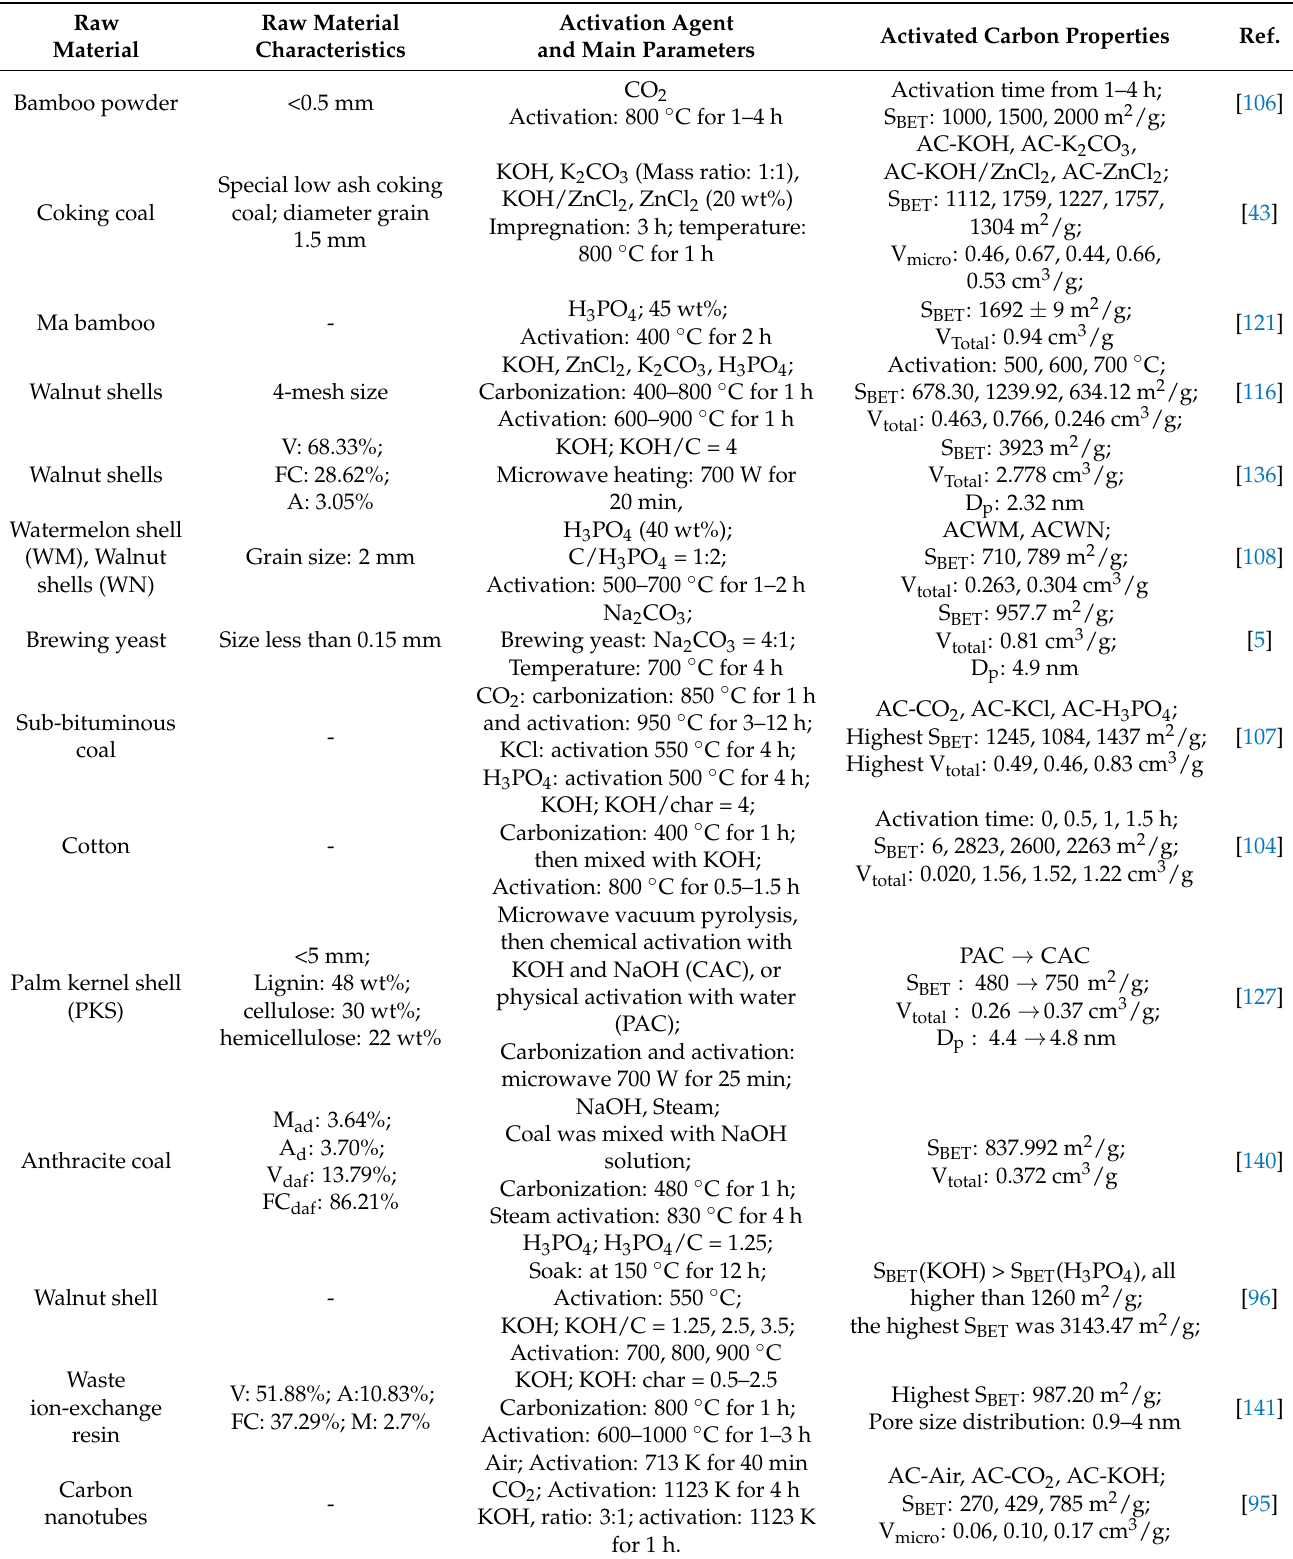
Table 1. Effects of raw materials and activation method on the properties of activated